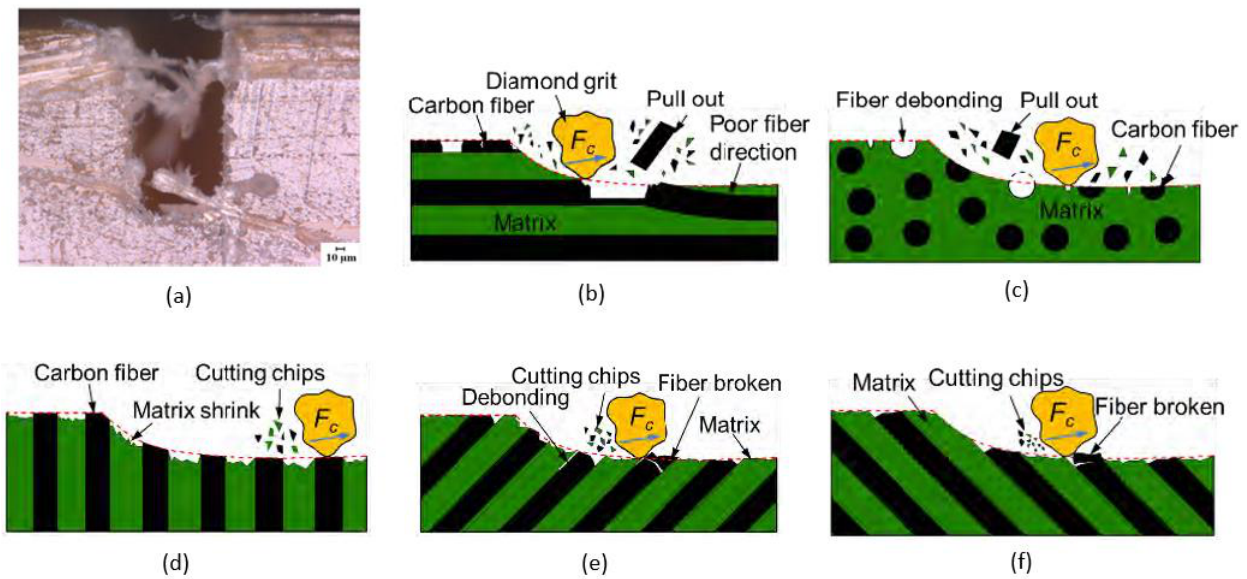
Figure 12. Surface morphology of AFRP composites after dicing: ( a ) morphology of the groove side; ( b ) schematic diagram of dicing mechanism with different fiber orientations for CFRP composites; ( c ) dicing direction parallel to fiber orientation; ( d ) dicing direction perpendicular to fiber orientation; ( e ) dicing direction with an angle of 45° to fiber orientation; ( f ) dicing direction with an angle of 135° to fiber orientation [48,52].